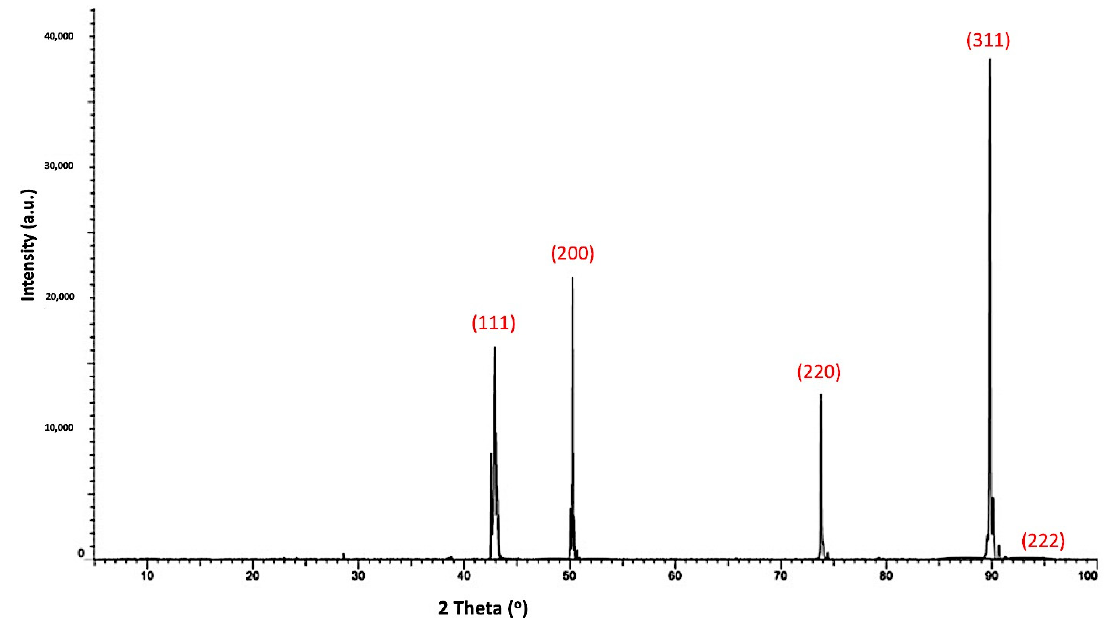
Figure 4. X-ray diffraction pattern of the as received uncoated polycrystalline cBN particles corresponding to JCPDS card number 25 ‐ 1033.